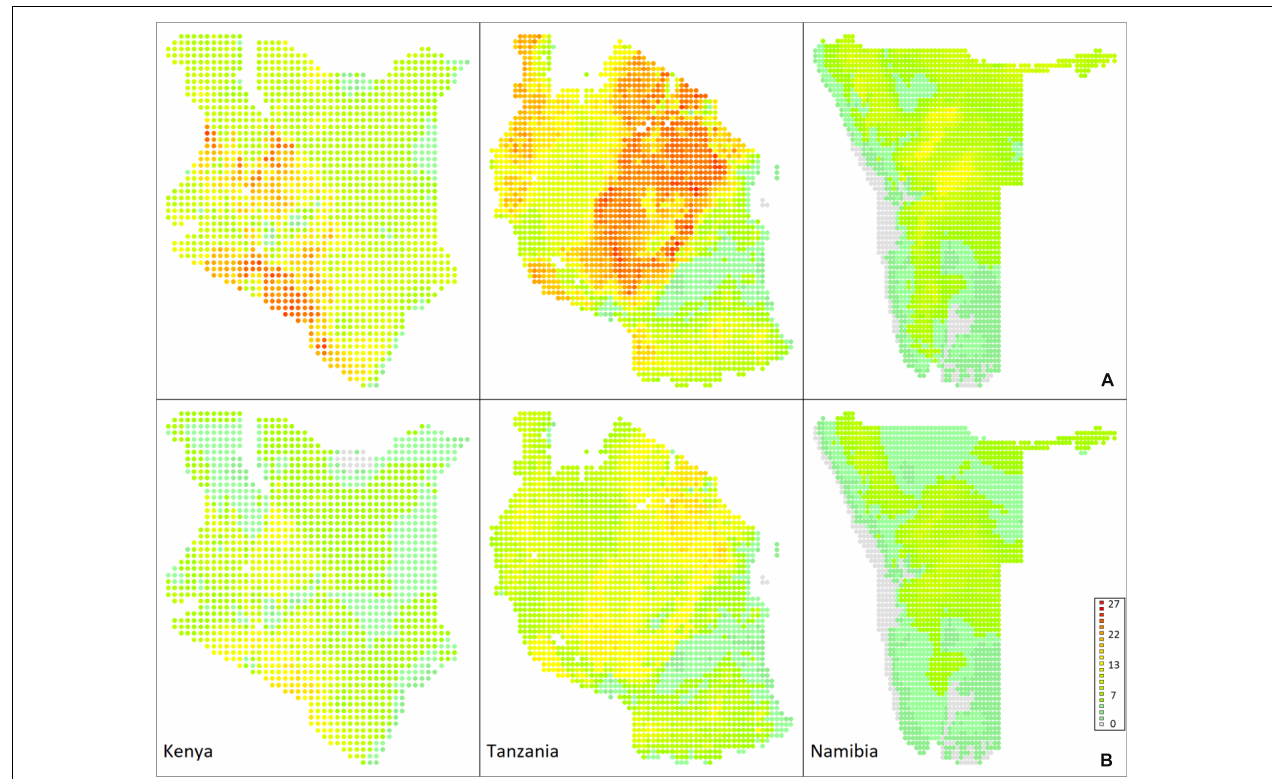
FIGURE 2 | Antelope biodiversity forecasts for 2080 in three sub-Saharan countries. (A) Heat map of the number of species for which bioclimatic envelopes overlap at a site. (B) Heat map of the species richness predicted under the conservative approach where species are unable to